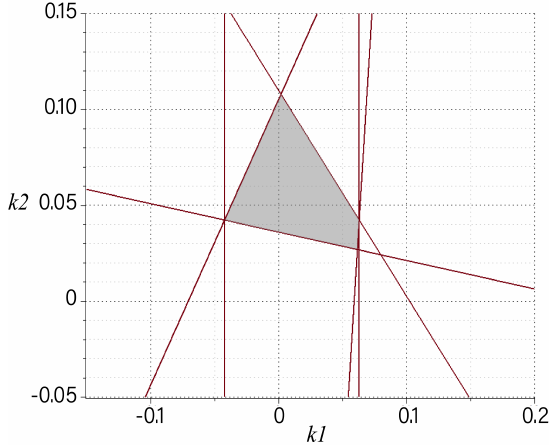
Figure 1. The stable gain matrix region.